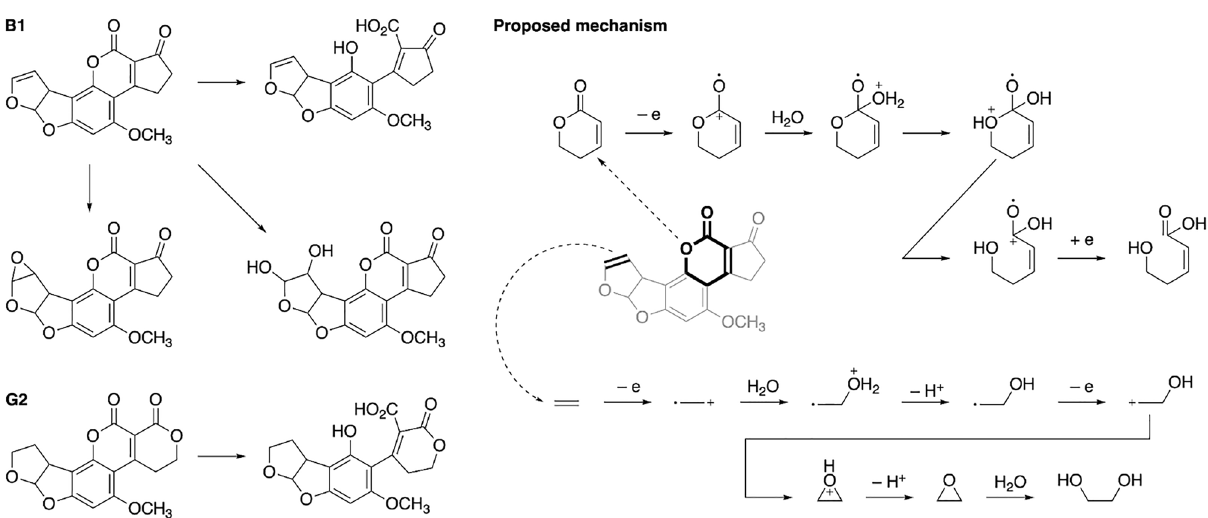
Figure 3. The main reaction products of AFB 1 and AFG 2 break-down, as identified by LC–MS and hypothetical reaction pathways. The main proposed mechanisms are the lactone ring opening and epoxide